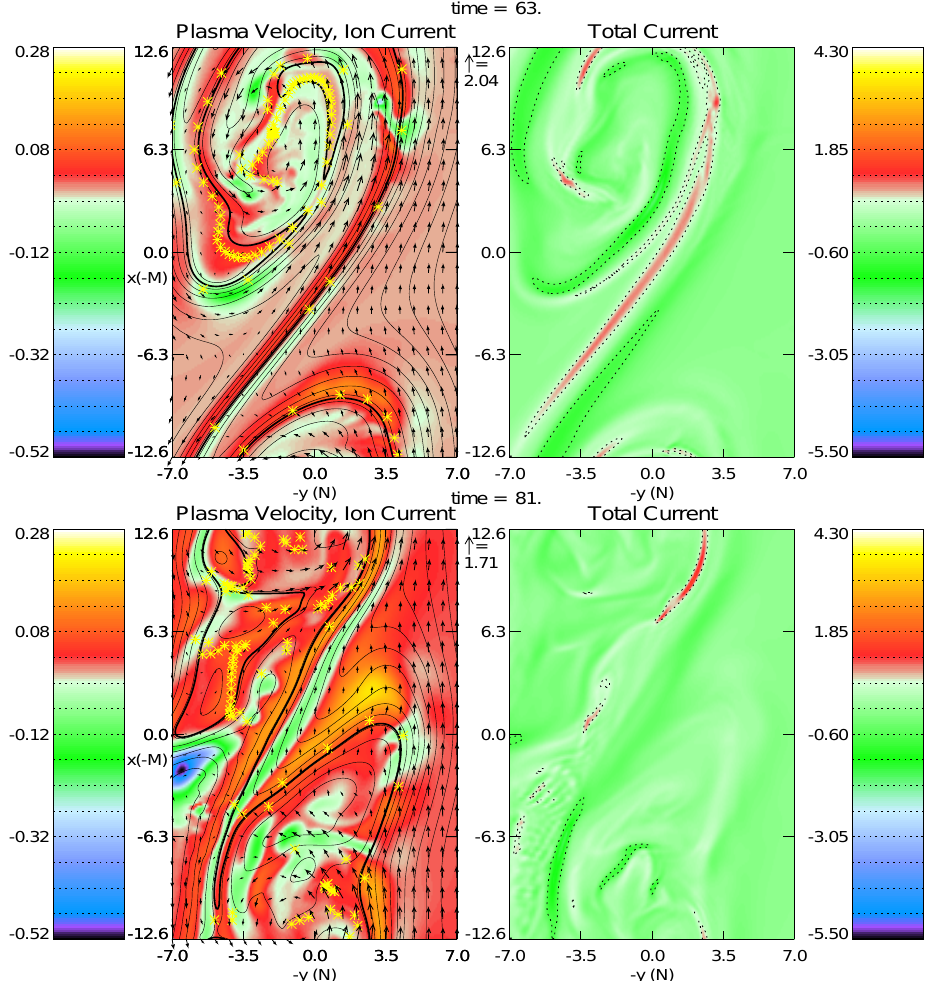
Fig. 5. KH vortex at t/τ A ≈ 63 and at t/τ A ≈ 81. Lines are magnetic field lines projected to x,y -plane and arrows are plasma velocity vectors. Color code represents ion current (left) and total current